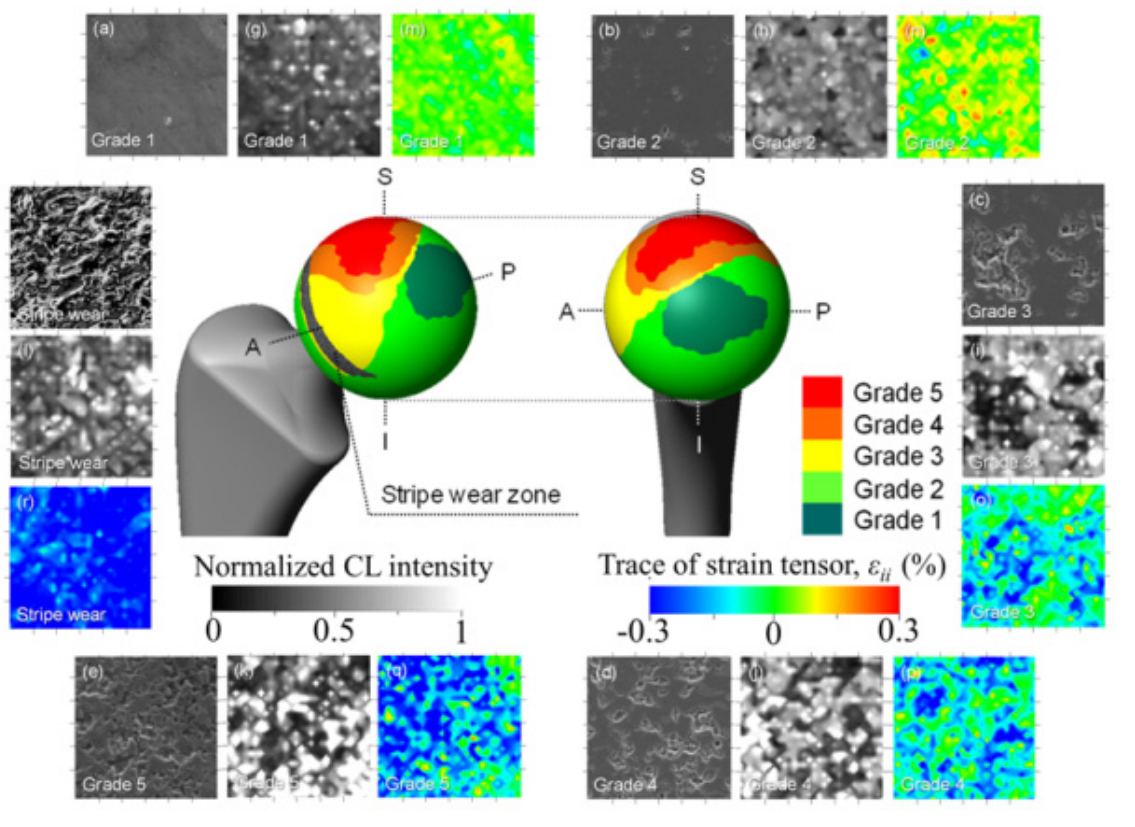
Figure 6. A macroscopic map of surface wear levels on a retrieved monolithic alumina-on-alumina femoral head retrieved after an in vivo period of 10.1 yr. Images in inset represent ( a – f ) topological; ( g – l ) stoichiometric; and ( m – r ) micromechanical features for in vivo worn areas with different grades of wear